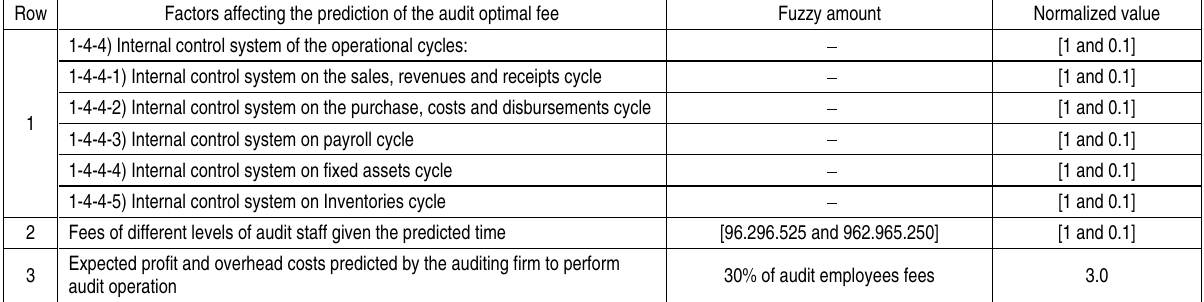
Table 5 (cont.). Normalized amounts of